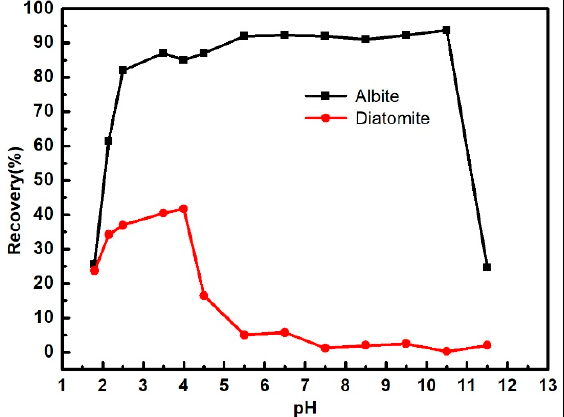
Figure 1. Recovery of diatomite and albite as a function of pH using 2.38 × 10 − 4 mol/L DDA.